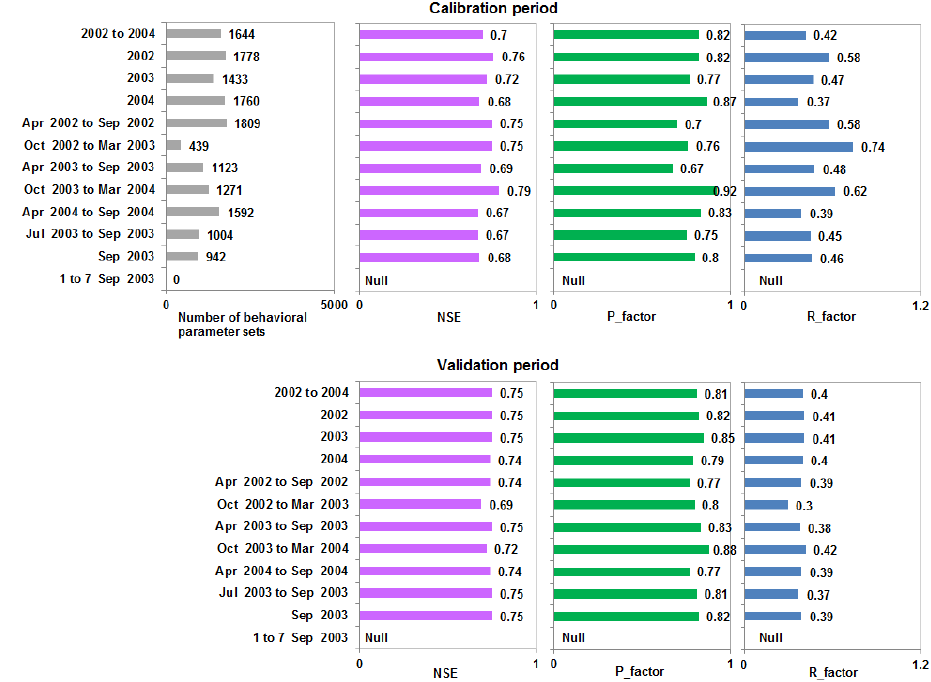
Figure 9. Model performance for the calibrations using short-period data in the Donghe Basin.